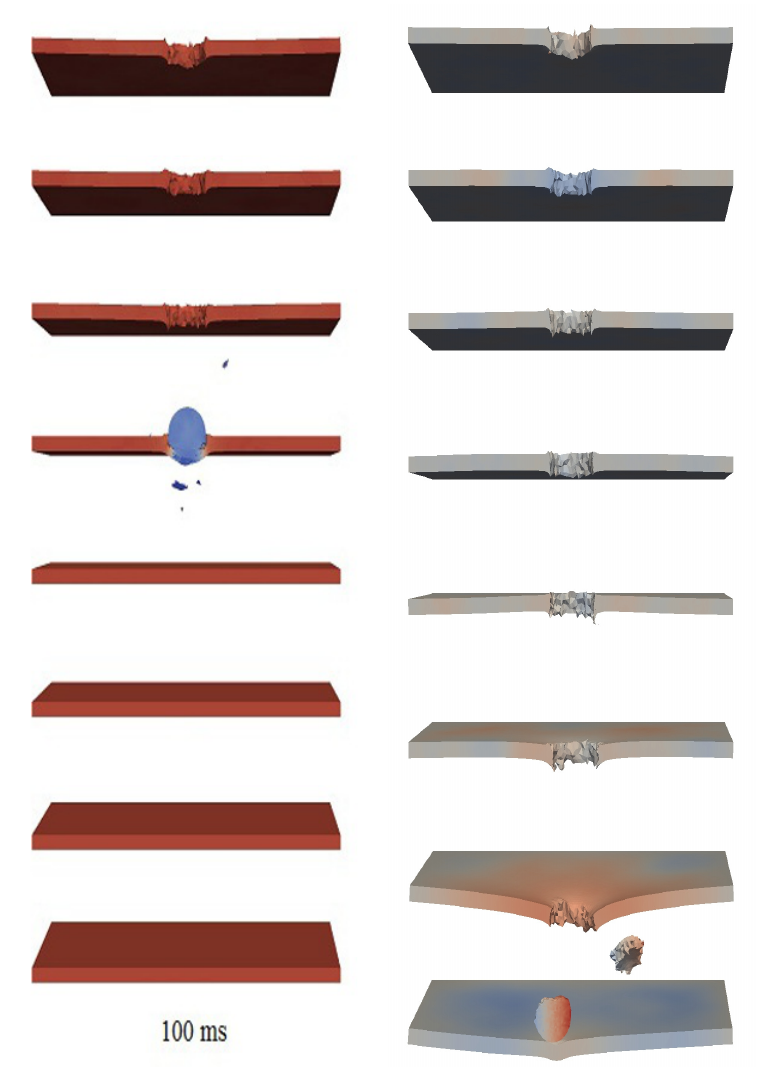
Figure 5. Calculated configurations of projectile and spaced